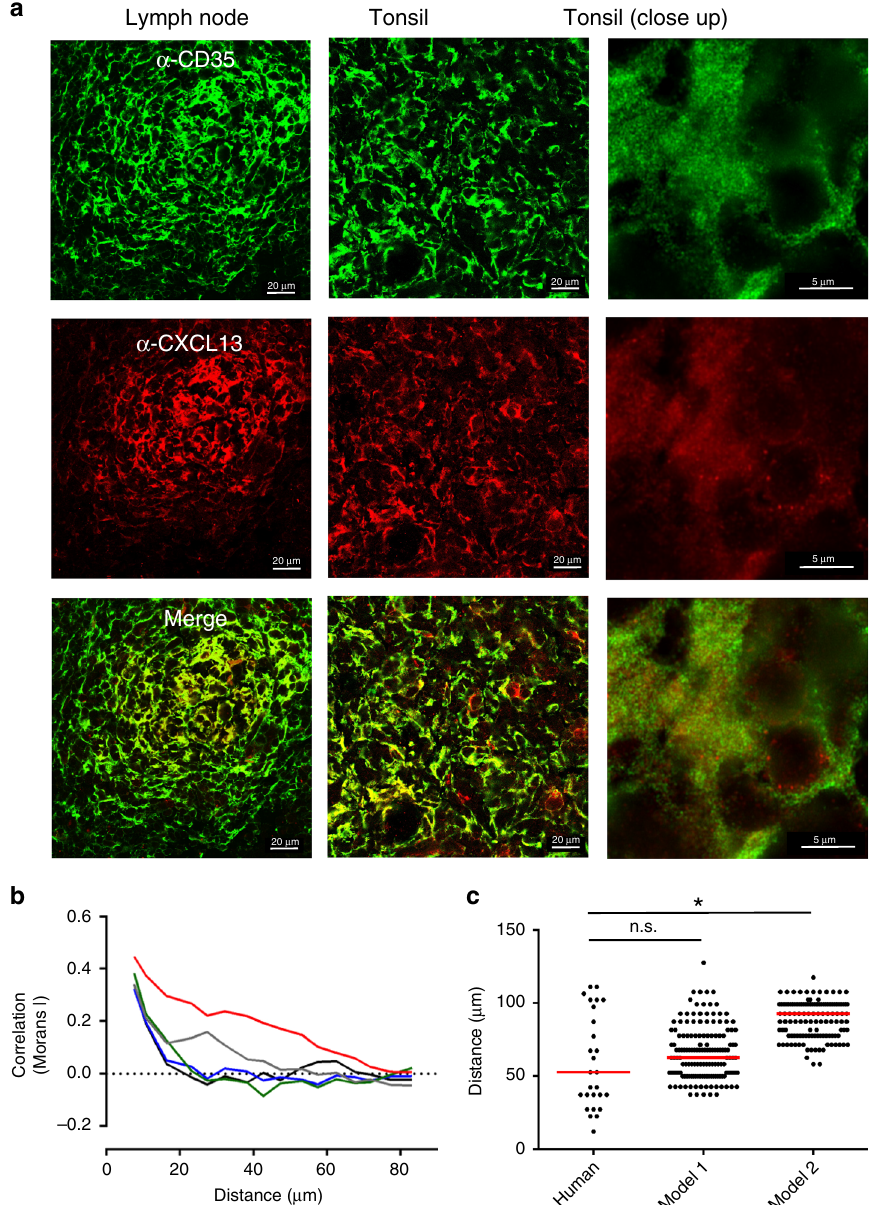
Fig. 4 Analyzing the spatial distribution of the immobile CXCL13 fraction. a IHC staining of the FDC marker CD35 (green) and CXCL13 (red) in human lymph nodes and tonsils. b The spatial autocorrelation of CXCL13 expression in samples from one patient, each line represents the spatial autocorrelation for a distinct follicle. c Comparison of the distances at which no statistically signi fi cant spatial autocorrelation (determined using permutation testing as described in “ Methods ” ) was detected in human tonsils, and for models 1 and 2. Each data point represents the distance at which no statistically signi fi cant spatial autocorrelation was observed for the intensity of anti-CXCL13 staining in a distinct tonsil follicle, with data pooled from fi ve different patients. The red line represents the median distance for each group with signi fi cance, the human dataset and each simulation model (run with 200 repeat executions) assessed using the Mann − Whitney U test ( p value = 0.06 for model 1 and p < 0.001 (denoted as *) for model 2). Source data are provided as a Source Data fi